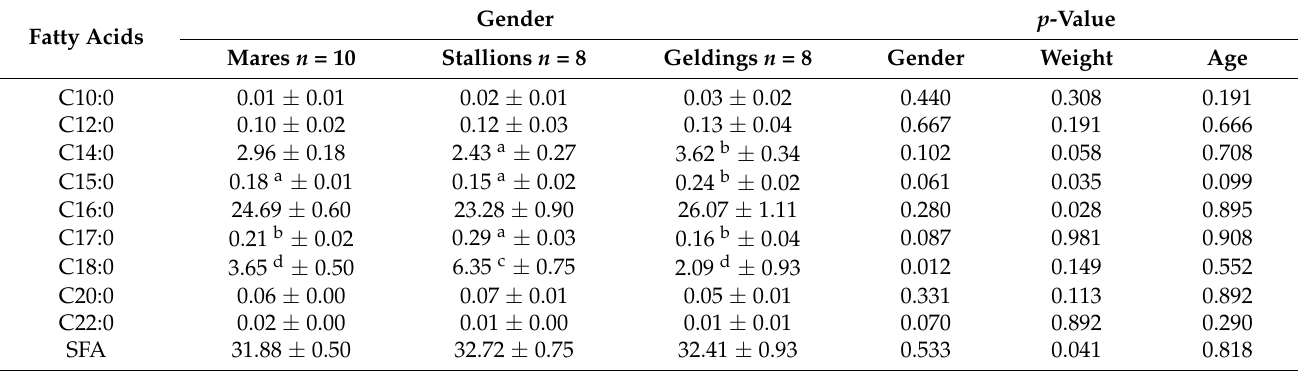
Table 6. Effects of gender, age, and carcass weight on saturated fatty acid (% of total FA) composition of horse meat lipids. Fatty